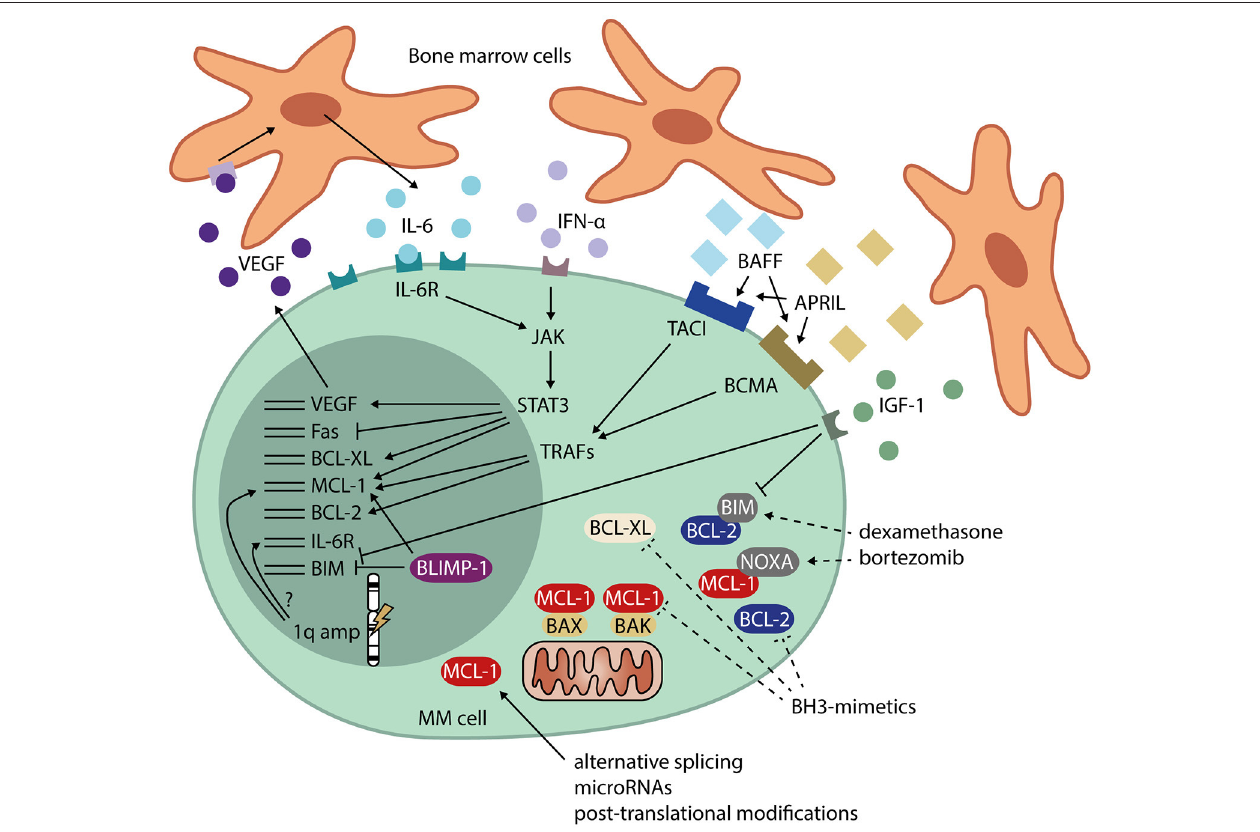
FIGURE 2 | Signals and cellular processes that mediate apoptosis resistance in MM. MM cells receive signals from the bone marrow microenvironment that stimulate their survival. These signals include IL-6 and IFN- α , leading to JAK/STAT signaling and expression of MCL-1, BCL-XL, and VEGF. VEGF, in turn, promotes IL-6 production by neighboring cells. Other signals from the bone marrow microenvironment include BAFF and APRIL, which signal via TRAFs and induce expression of MCL-1 and BCL-2. IGF-1 signaling downregulates BIM, transcriptionally as well as post-translationally. MM cells also have high expression of the PC transcriptional regulator BLIMP-1, which promotes MCL-1 and represses BIM expression. Amplification of the 1q chromosome arm often occurs in MM. The genes for both MCL-1 and the IL-6 receptor (IL-6R) are present on this locus, possibly leading to overexpression in 1q-amplified MM. In addition to transcriptional regulation, MCL-1 is heavily regulated post-transcriptionally, which may contribute to the high MCL-1 protein levels found in MM. Dashed lines represent methods for interference in apoptosis resistance by MM drugs dexamethasone and bortezomib, and by BH3-mimetics. APRIL, a proliferation-inducing ligand; BAFF, B-cell activating factor; BCMA, B-cell maturation antigen; BH-3, BCL-2 homolog 3; BLIMP-1, B lymphocyte-induced maturation protein 1; IFN- α , interferon alpha; IGF-1, insulin-like growth factor 1; IL-6, interleukin 6; IL-6R, interleukin 6 receptor; JAK, janus kinase; STAT3, signal transducer and activator of transcription 3; TACI, transmembrane